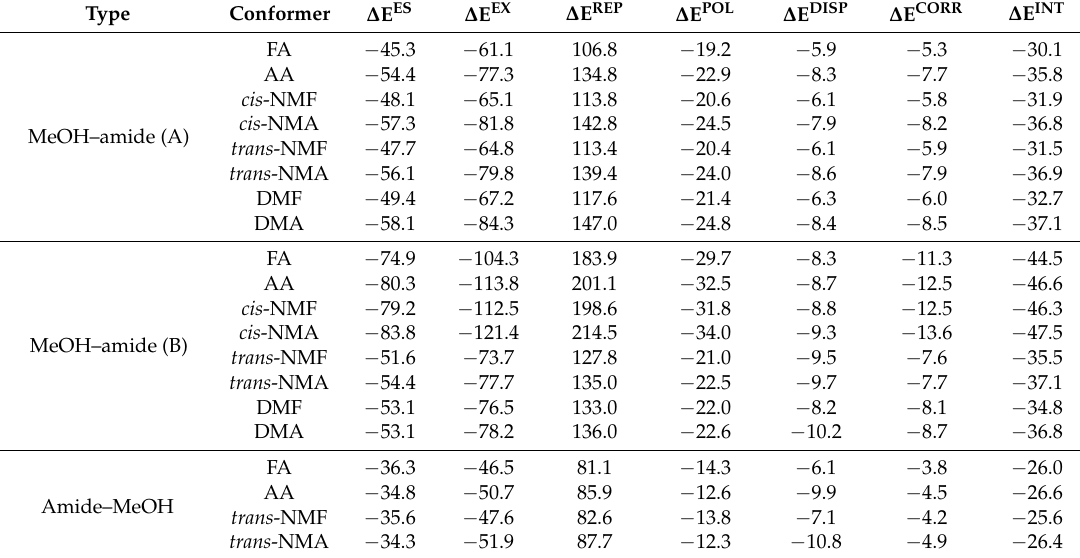
Table 5. Results of generalized Kohn-Sham energy decomposition analysis (GKS-EDA) for the MeOH–amide and amide–MeOH complexes at the B3LYP-D3/aug-cc-pVTZ level (all values in kJ · mol − 1 ) a